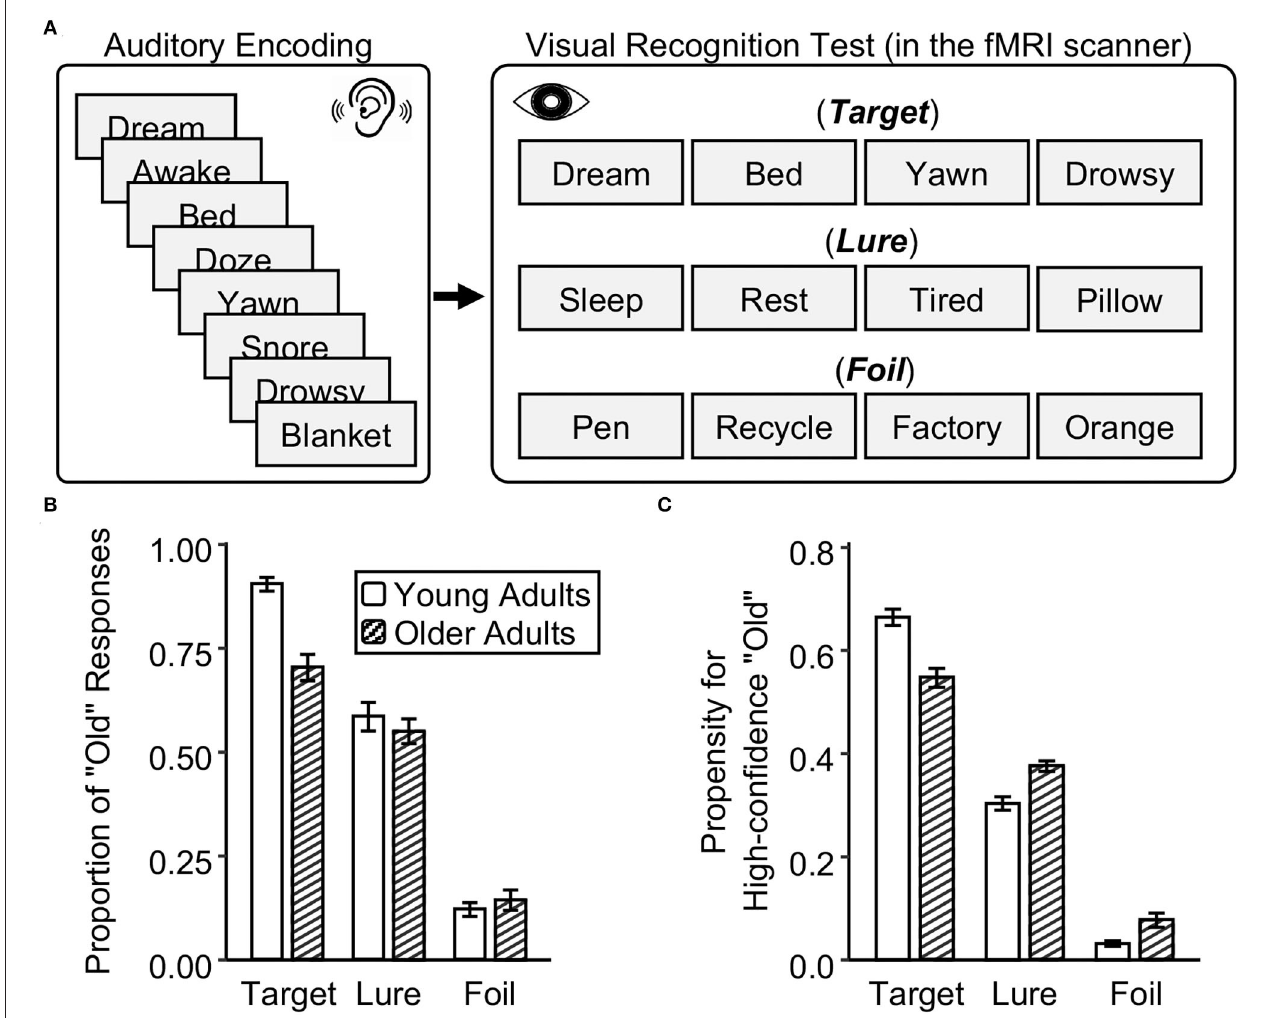
FIGURE 1 | Experimental design and memory performance in young and older adults. (A) After listening to words, young and older adults were asked to make memory judgments on studied targets, similar lures, and novel foils in a visual recognition test in the fMRI scanner. (B) The proportion of “old” responses in the recognition test. (C) The propensity for high-confidence recognition. The error bar indicates the standard error of the